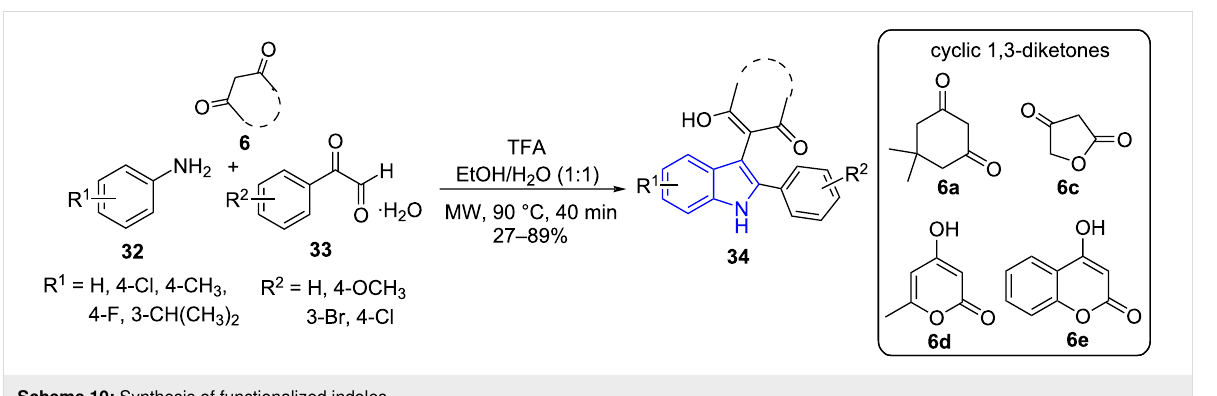
Figure 3: Indole-containing pharmacologically active molecules.